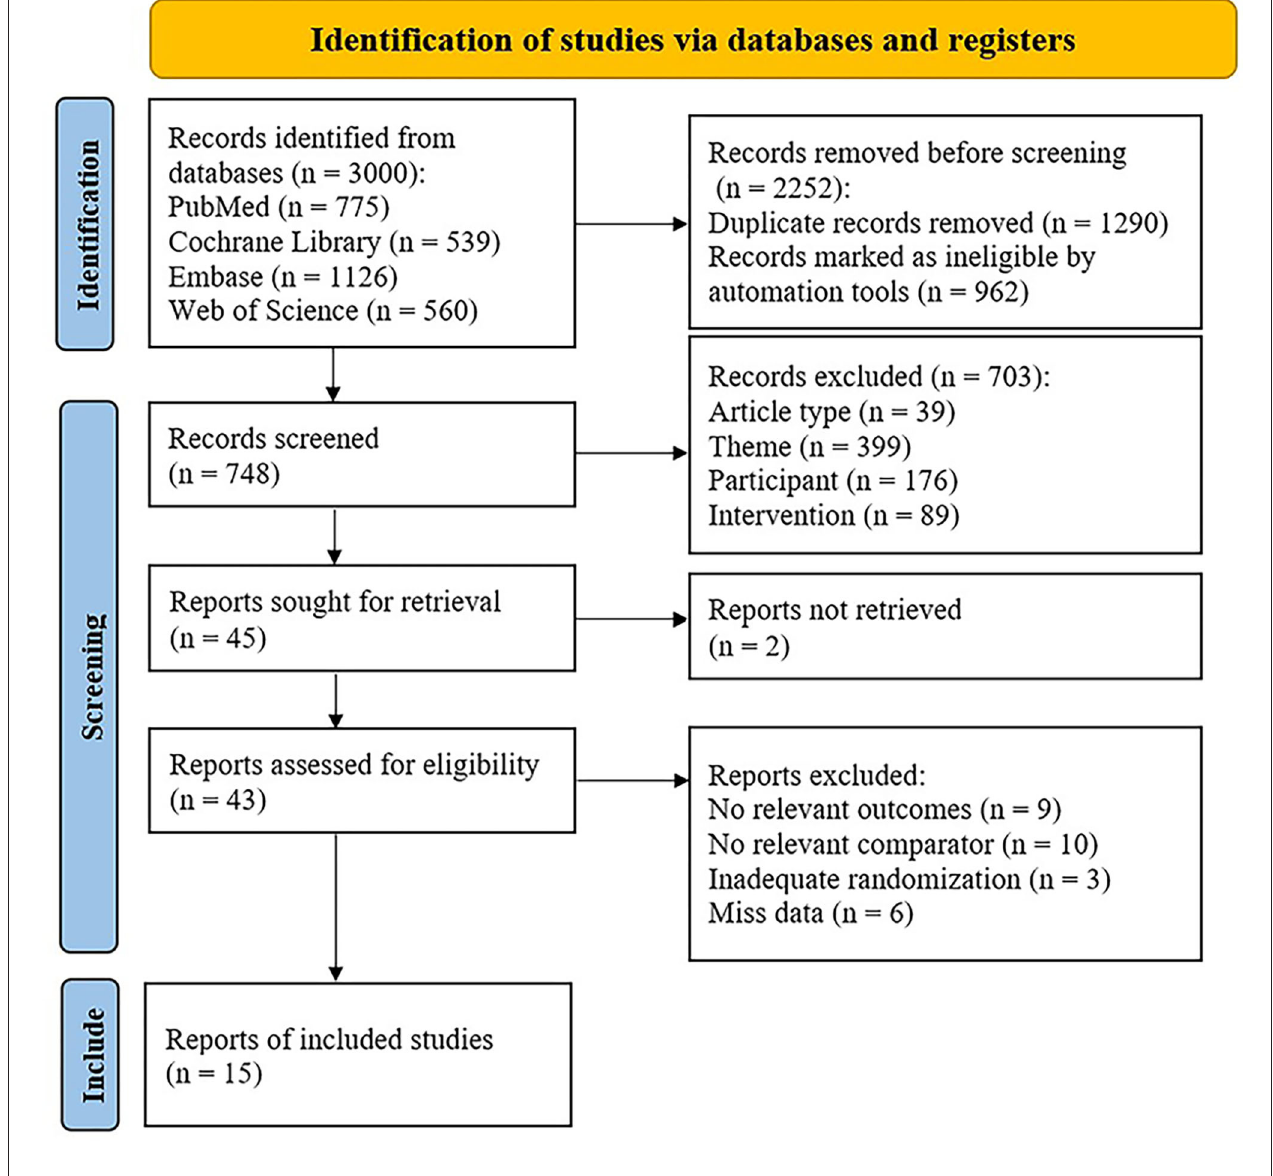
FIGURE 1 | Flow diagram of the study